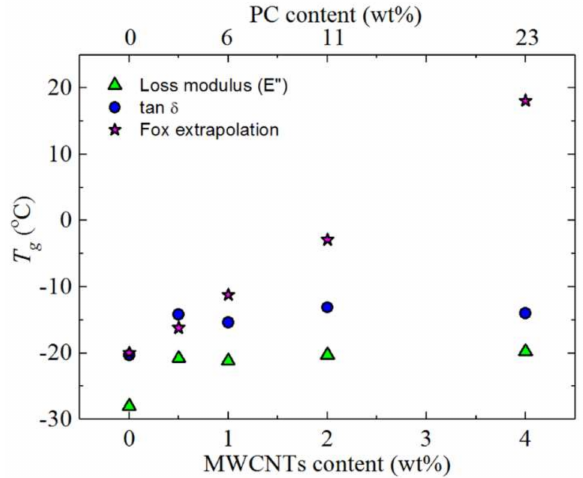
Figure 5. Glass transition temperatures of neat PBS and the PBS/(PC/MWCNTs) nanocomposites as a function of MWCNTs content (the corresponding PC content is indicated in the top x-axis). The Fox extrapolation T g data was obtained using the tan δ